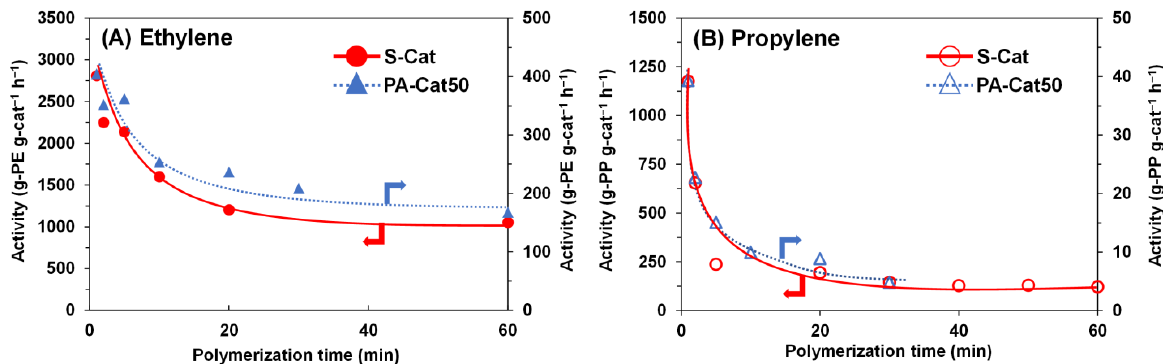
Figure 5. Polymerization kinetics of ( A ) ethylene and ( B ) propylene homo-polymerization with S-Cat and PA-Cat50. Table 2. Summary of ethylene and propylene polymerization results.